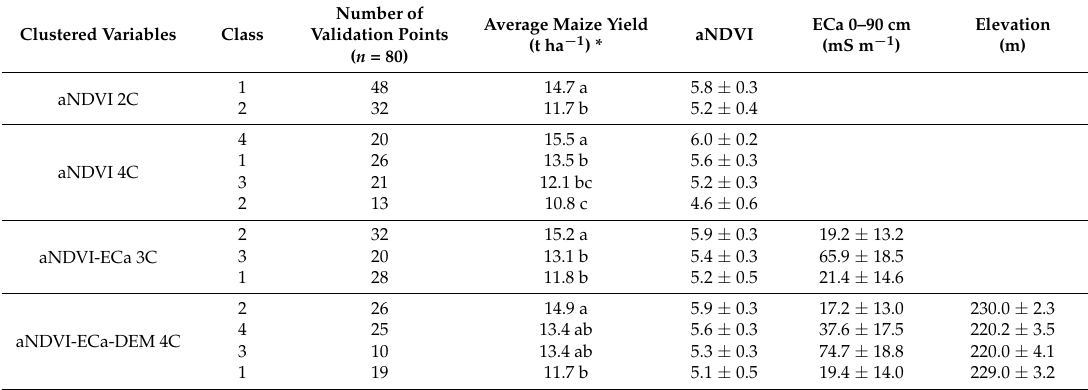
Table 5. Analysis of variance (ANOVA) of maize yield according to classes for the different types of proposed potential management zones